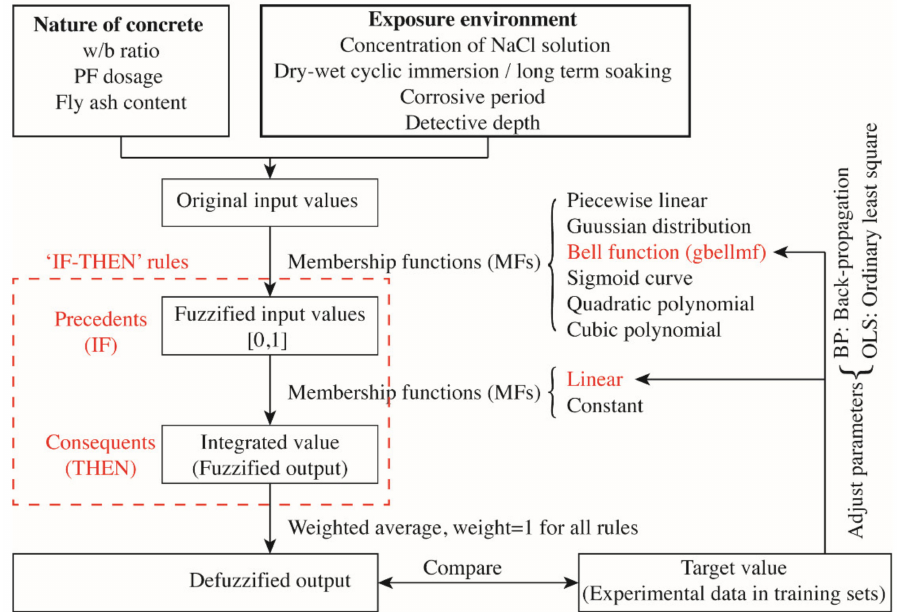
Figure 5. Data processing and algorithms of the neuro-fuzzy inference system